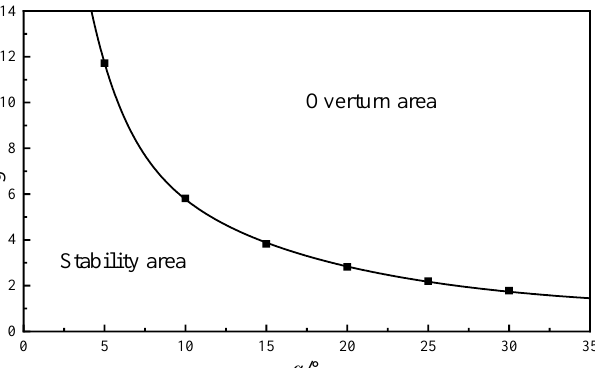
Figure 5. Relationship between height of support unit gravity center h g and limit angle α .